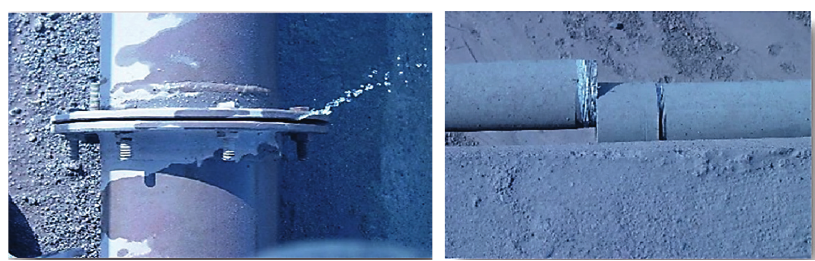
Figure 5: Damage occurred from Bam earthquake.